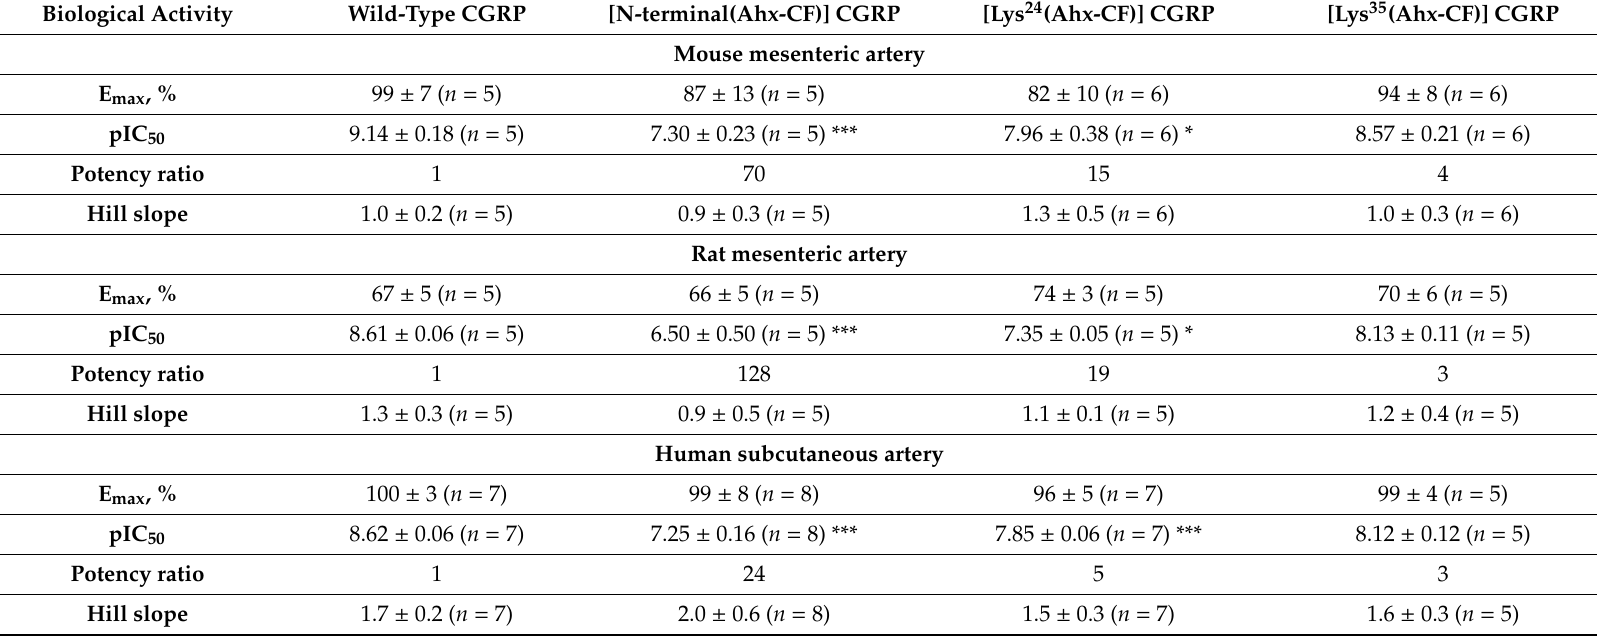
Table 1. E max , Hill coe ffi cient, pIC 50 values, and potency ratios when comparing wild-type CGRP to the three fluorescently tagged CGRP analogues in three di ff erent species (mouse, rat, and